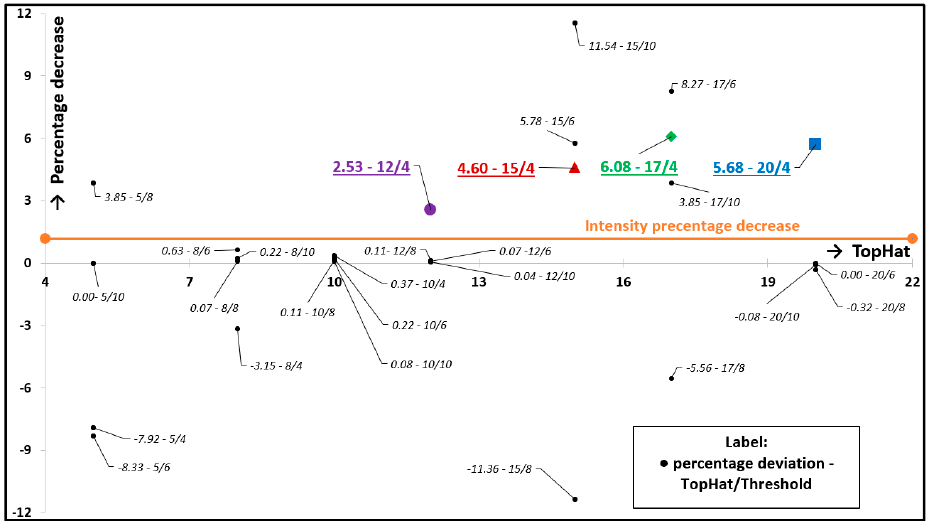
Figure 10. Knockout chart.